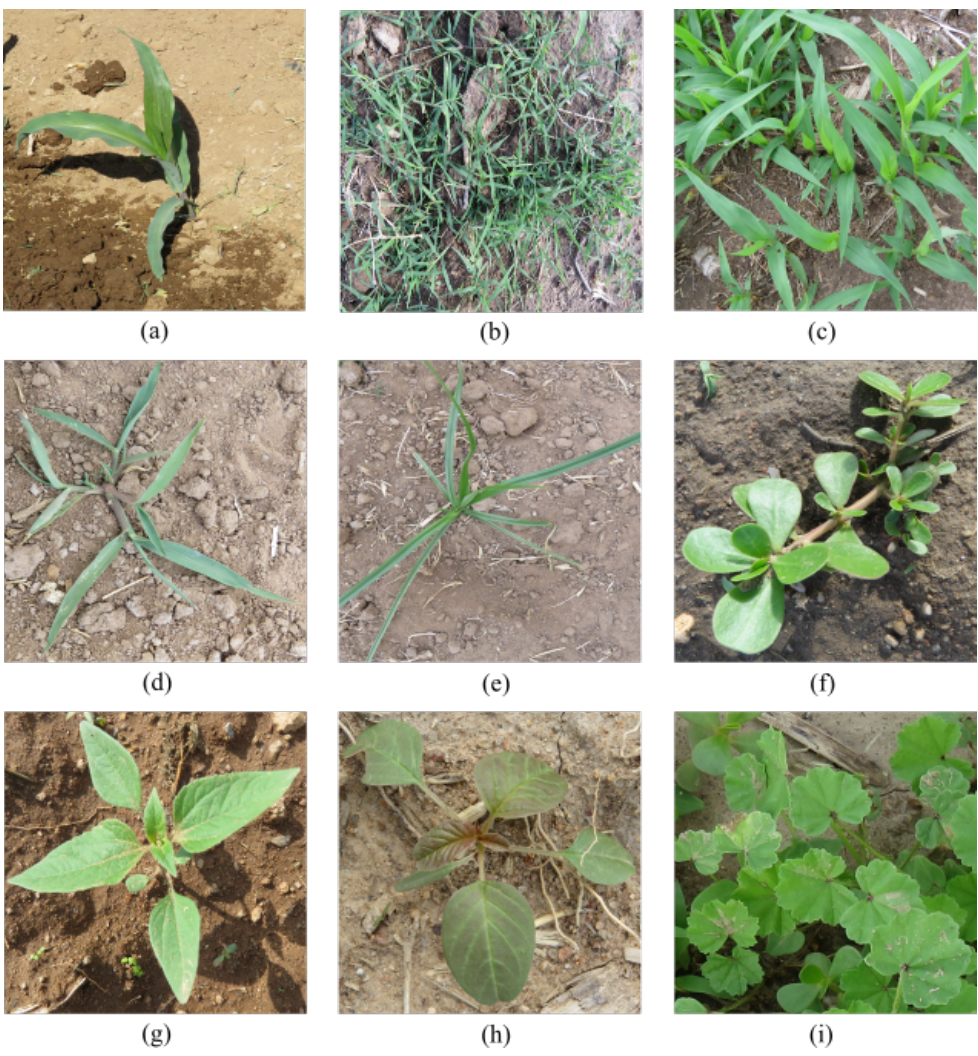
Figure 3. Sample of plants that intagrates the dataset. ( a ) Zea mays L. ( b ) Cynodon dactylon . ( c ) Eleusine indica . ( d ) Digitaria sanguinalis . ( e ) Cyperus esculentus . ( f ) Portulaca oleracea . ( g ) Tithonia tubaeformis (Jacq.) Cass. ( h ) Amarantus spinosus . ( i ) Malva parviflora